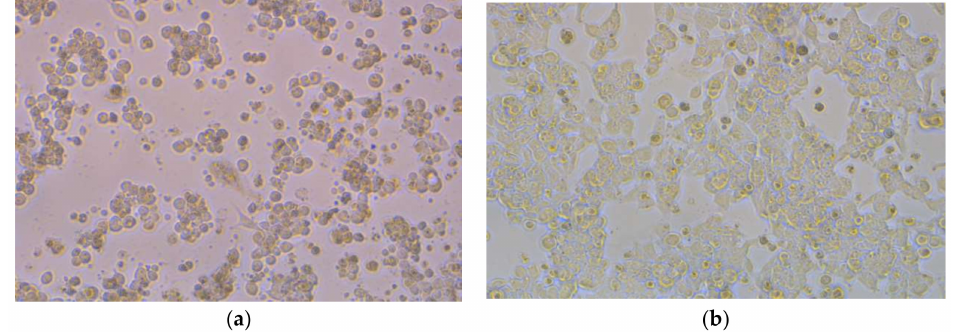
Figure 4. Morphological changes in LoVo cells treated with 46.15 µ g/mL AgNPs mediated by Ferula asafetida extracts for 72 h ( b ); ( a ) is the control. Images were captured by a phase contrast microscope (Leica, Germany), (Magnification: 200 ×